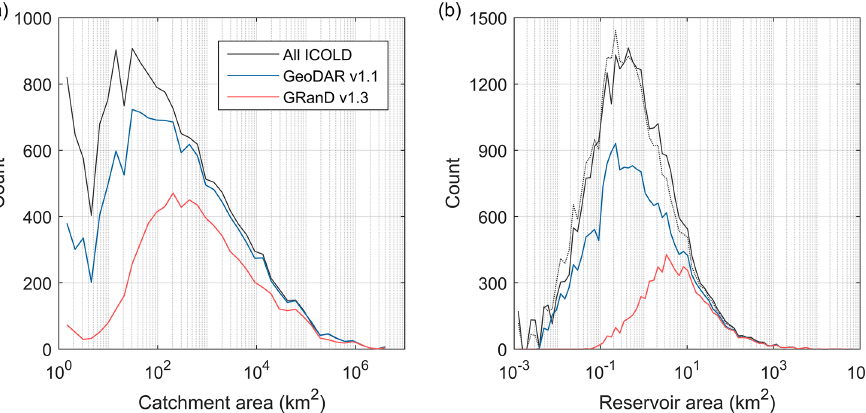
Figure 11. Comparison among GeoDAR, the ICOLD WRD, and GRanD by reservoir catchment area and reservoir area. (a) Frequency (count) distributions by reservoir catchment area. Statistics were based on 40 bins between the minimum and maximum catchment areas (i.e., 0 to 4 . 04 × 10 6 km 2 ). (b) Frequency distribution by reservoir area. Statistics are based on 80 bins between the minimum and maximum reservoir areas (i.e., 0 to 6 . 72 × 10 4 km 2 ). All bins (except the initial one) are of equal size on a logarithmic scale. Considering that catchment areas are often missing in the WRD, a smaller bin size was used to generate smoother distribution curves. Reservoir areas for GeoDAR were based on mapped polygons, whereas reservoir areas for the WRD were based on attribute values when available (see note for Table 5). For comparison, the dotted curve in panel (b) shows an alternative distribution where the polygons took precedence in presenting reservoir areas for the